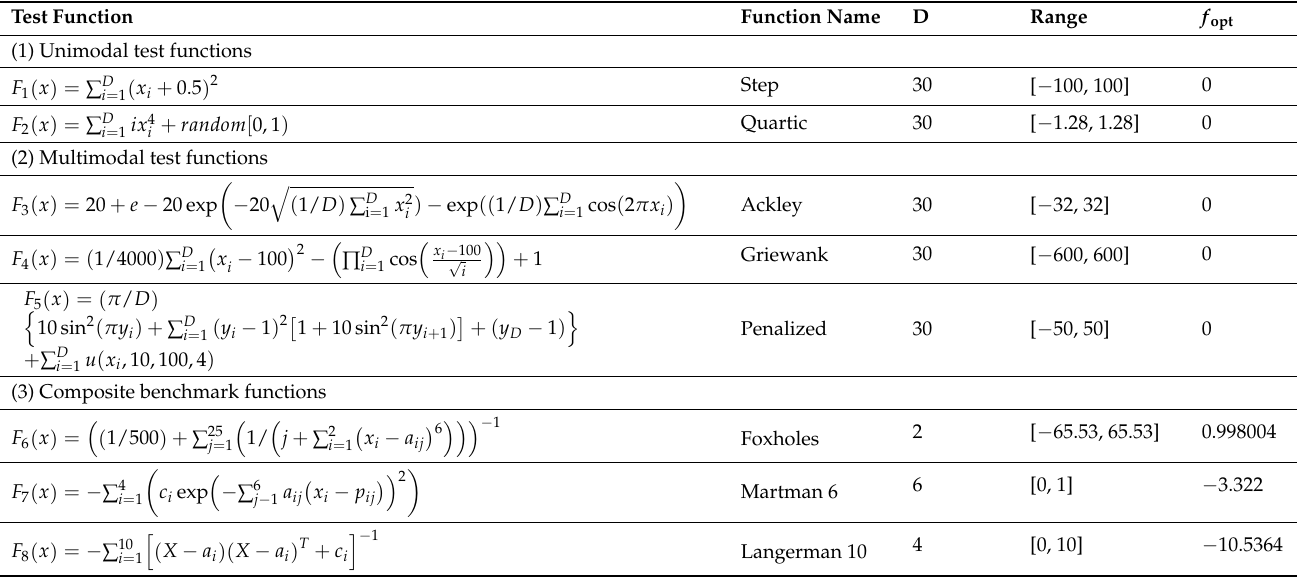
Table 2. Parameter settings of test functions.